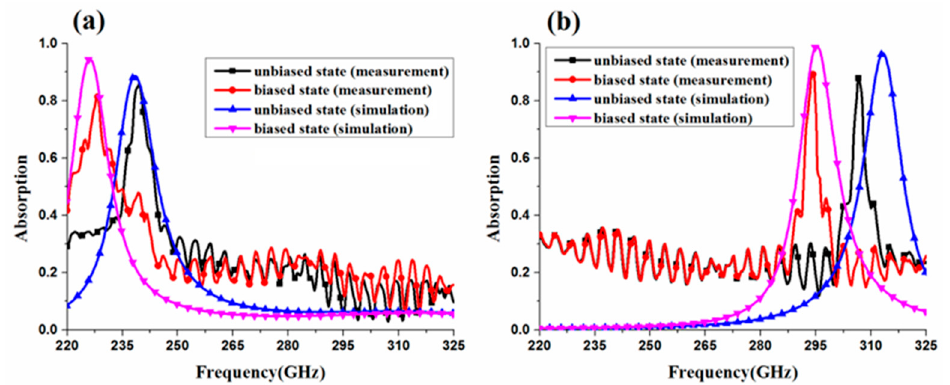
Figure 10. Simulated and measured absorption in unbiased and full biased states for ( a ) the TE-polarized incident wave and ( b ) the TM-polarized incident wave.